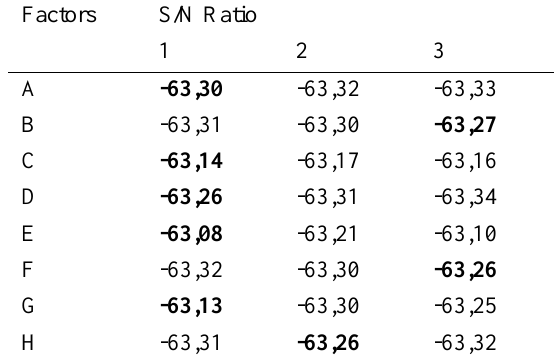
Figure 5. Steps of the algorithm